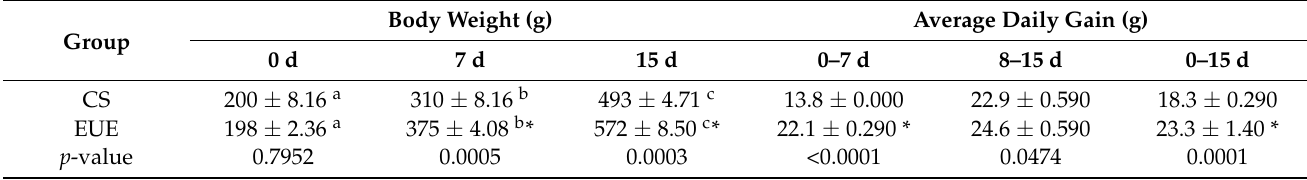
Symbol * indicates a significant difference at p < 0.05 between the Eucommia ulmoides group and the control group at the same time. a,b,c Values with different letters within the same row are significantly different ( p < 0.05). Values are the mean ± SEM. Results are means of 15 samples obtained from the test chicks of each control and experimental